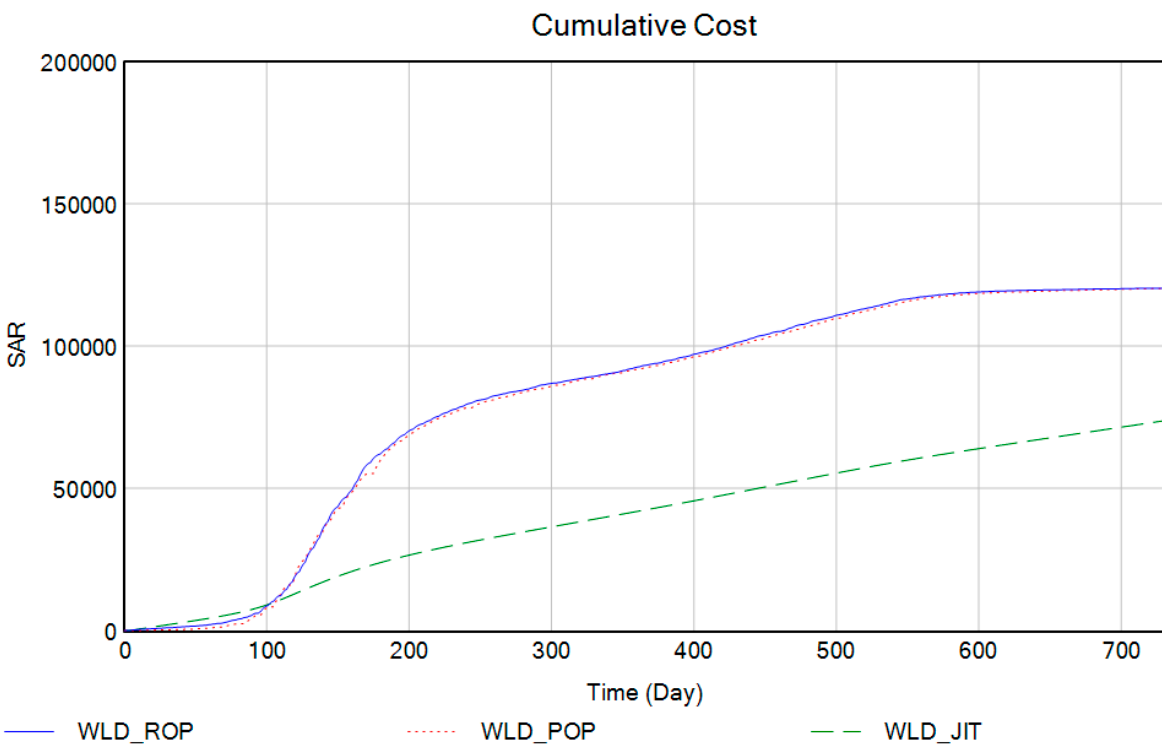
Figure 3. Flow chart representing the various situations.